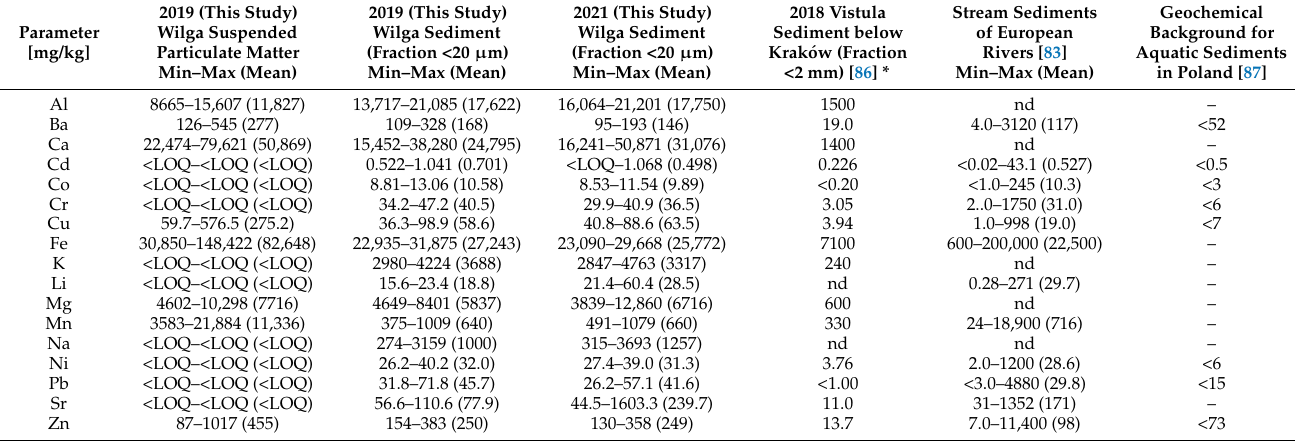
Table 2. Statistical parameters of selected elements in suspended particulate matter (SPM) and sediment of the Wilga River (2019, 2021), in Vistula River sediment (2018), European rivers and geochemical background for aquatic sediments in